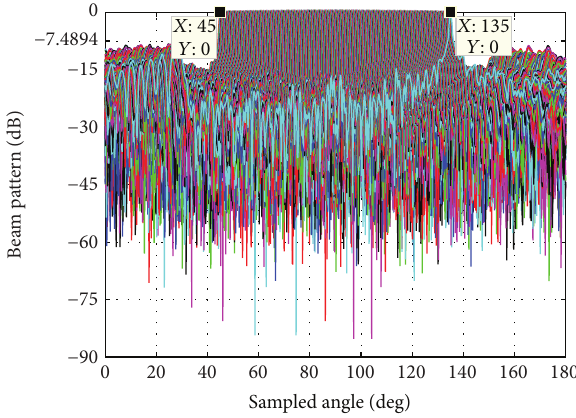
Figure 7: Beam pattern optimized by the hybrid algorithm of GA and convex optimization.